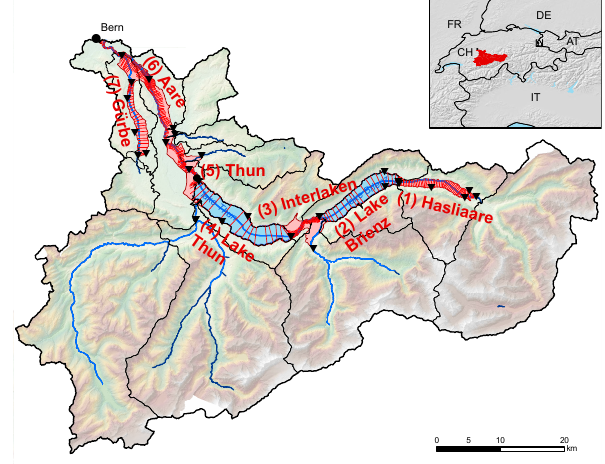
Figure 2. The Aare River catchment upstream of Bern, Switzerland. The sub-catchments of the hydrological model are divided by black lines. The black triangles indicate the coupling points between the hydrologic and the 2-D inundation model. The 1-D routing model covers all floodplains (red lines) and the lakes (blue). The flood- plains that are covered by the individual 2-D inundation models nested into the 1-D routing model are marked and labelled in